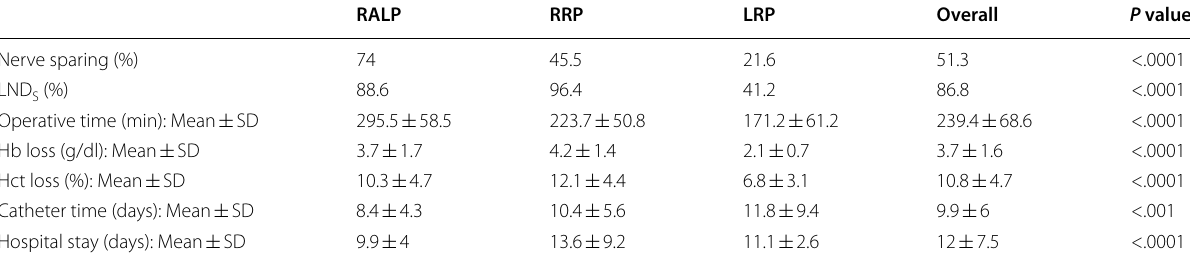
Table 2 Perioperative data